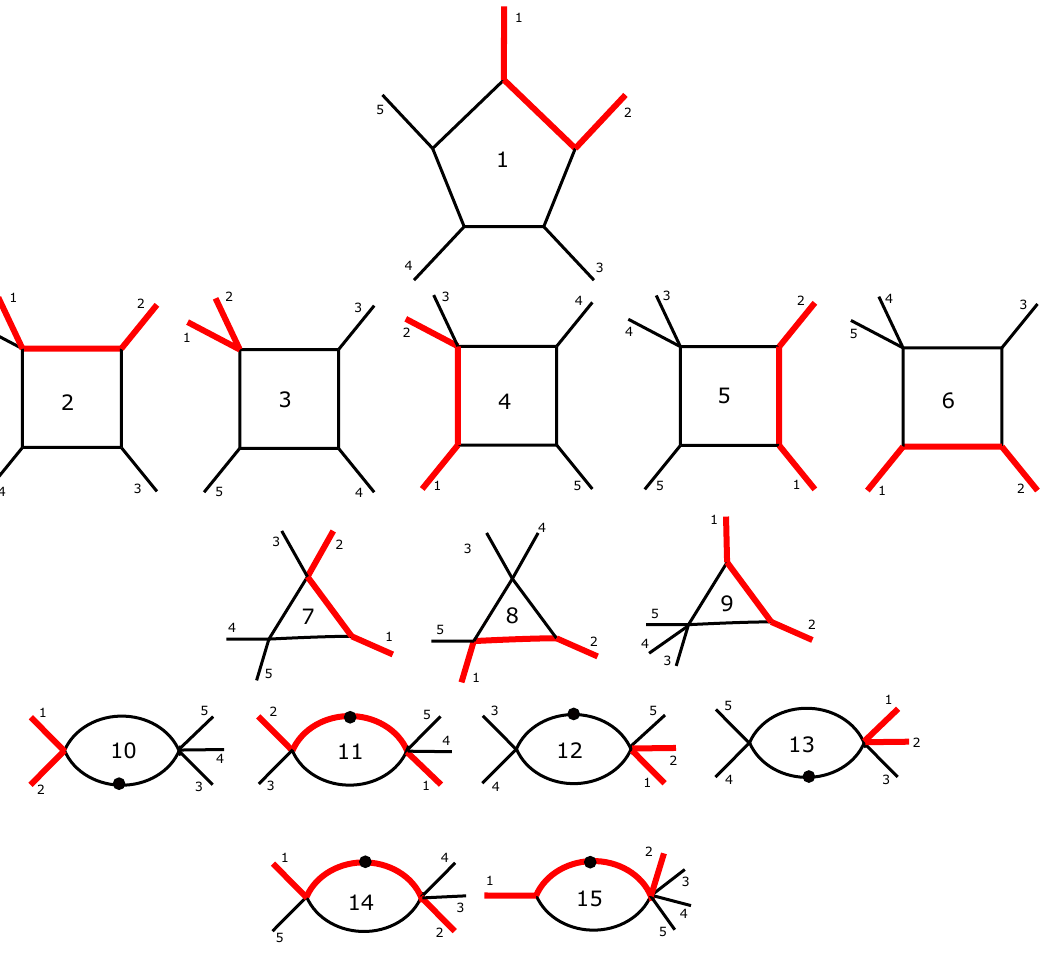
Figure 3 . The 15 master integrals appearing in the T 1 topology, denoted by I ’s in (4.11). Red/black lines indicate massive/massless particles respectively. Dotted internal lines indicate propagators with an additional power in the denominator of the integral. Each integral is associated with a kinematic normalisation which ensures the basis leads to a canonical form differential